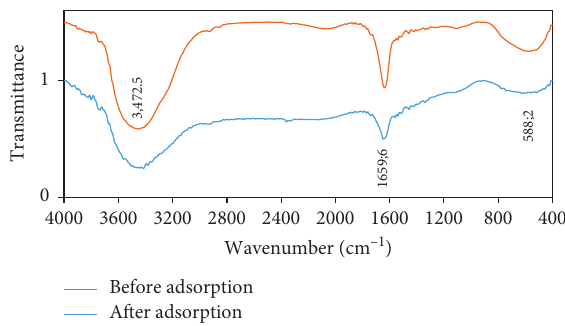
Figure 20: FTIR spectra of WM before and after